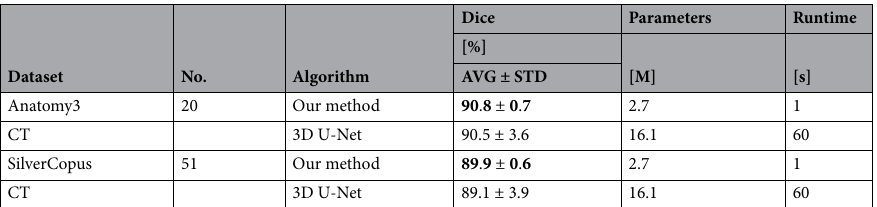
Table 1. Mono-modal liver segmentation accuracy, trainable parameters (in millions), and run-time comparison for the Anatomy3 and SilverCopus datasets. The number of parameters for the proposed methods is the sum of actor and value